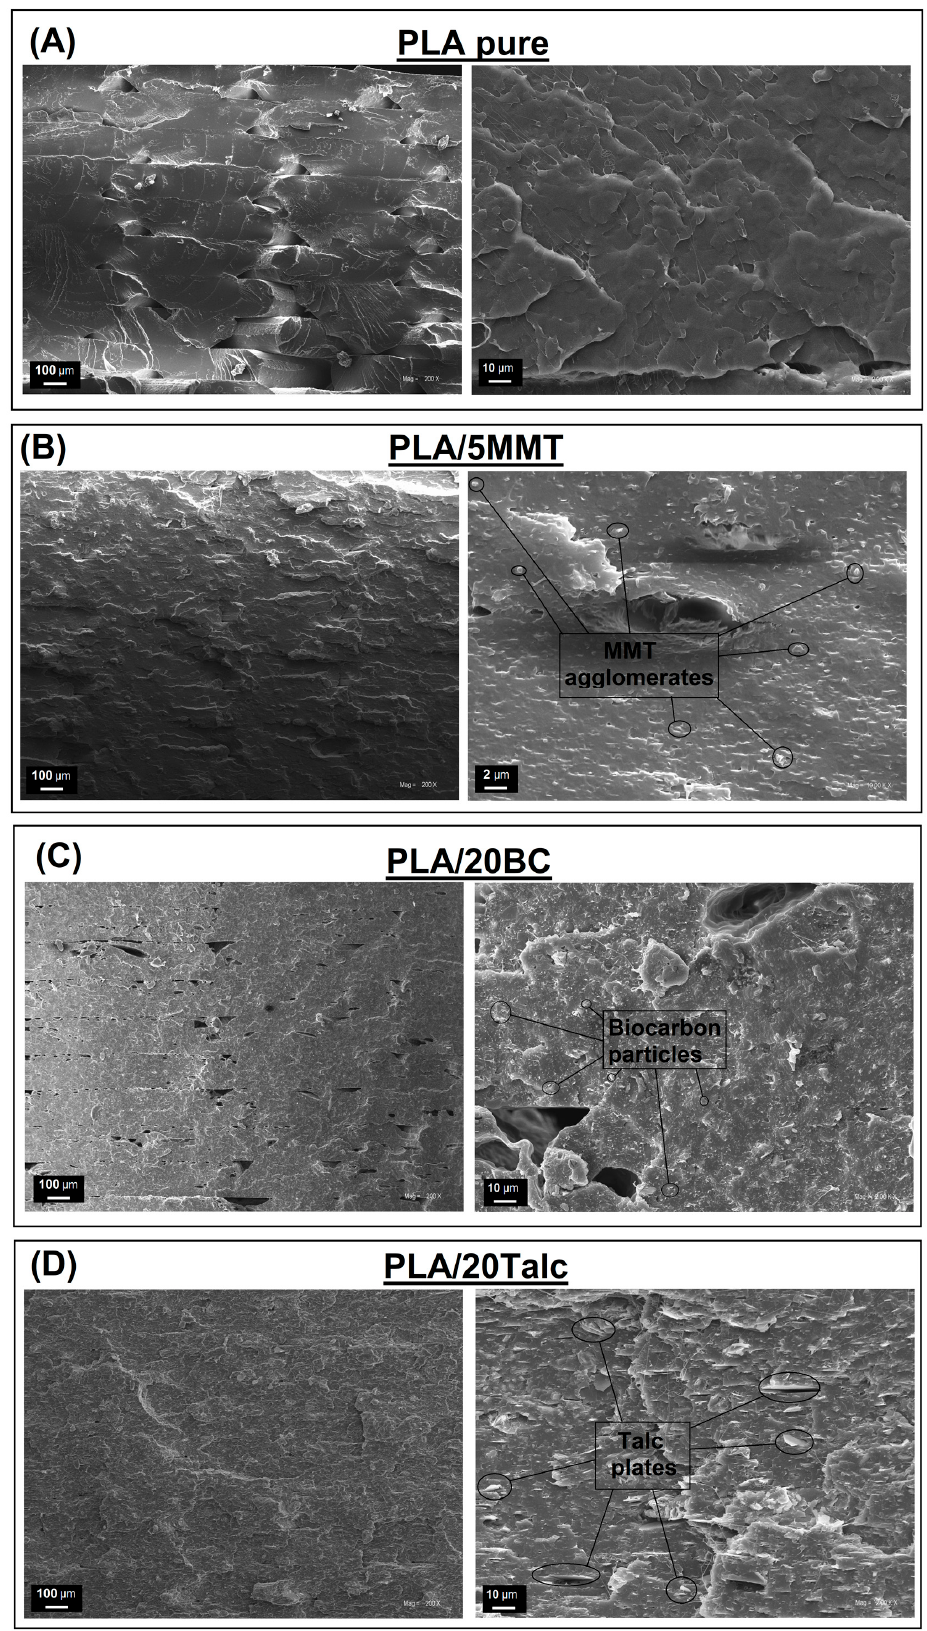
Figure 2. The SEM observations results. Pictures are presenting the fractured surface of ( A ) pure PLA, ( B ) PLA/5MMT ( C ) PLA/20BC and ( D ) PLA/20Talc